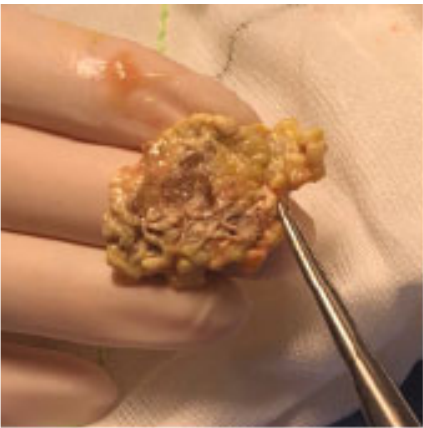
Figure 4: Wound at one-week postoperative follow-up.